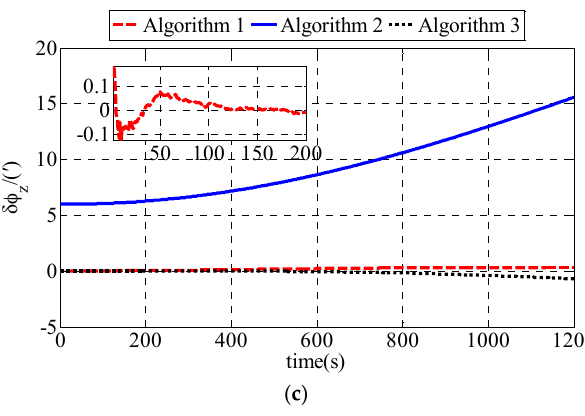
 ; ( b ) Estimation errors x